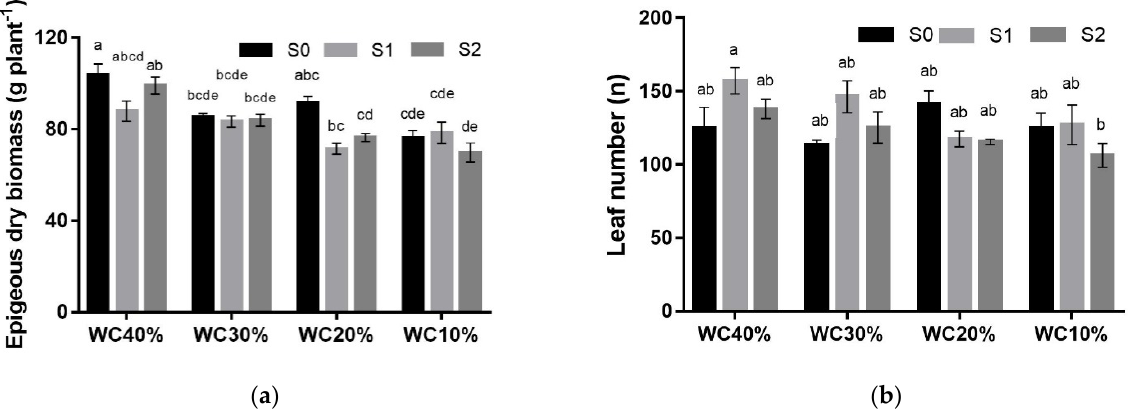
Figure 2. Interaction effect of drought (WC40%: control; WC30%: light drought stress; WC20%: moderate drought stress, WC10% severe drought stress) × saline aerosol treatment (S0: Distilled water, S1: 50% Synthetic seawater solution, S2: 100% Synthetic seawater solution) for Viburnum plants on epigeous dry biomass ( a ) and leaf number ( b ). Data are means ± standard error ( n = 3). Three biological replicates were used for the measurements. Data were subjected to two-way ANOVA and differences among means were determined using Tukey’s post-test. Different letters indicate statistical differences for p < 0.05.